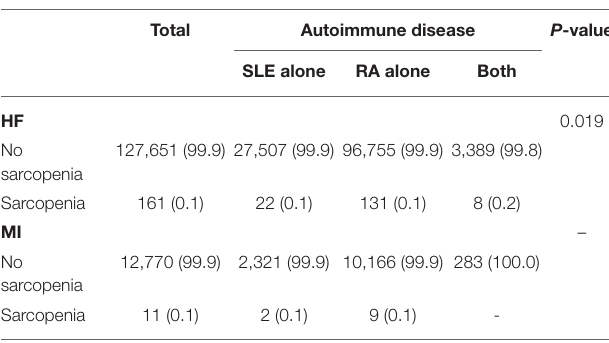
TABLE 3 | Prevalence of sarcopenia in patients with HF or MI, stratified by